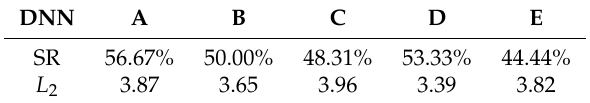
Table 5. Influence of different architectures on the final results. Here, ‘SR’ means the success